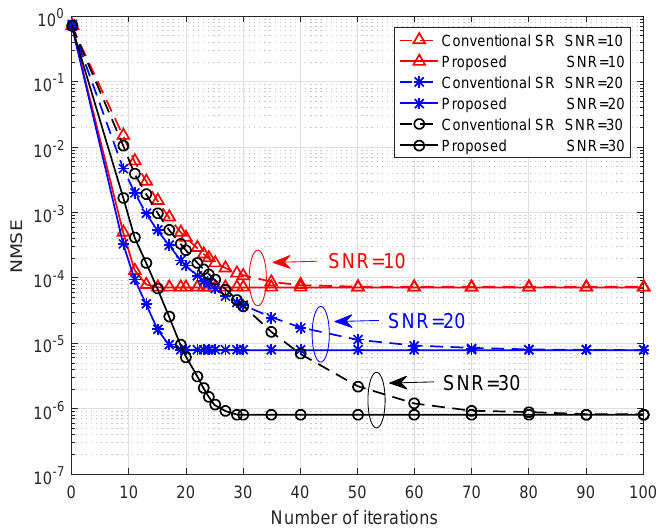
Figure 2. NMSE versus the number of iterations. SR, super-resolution.